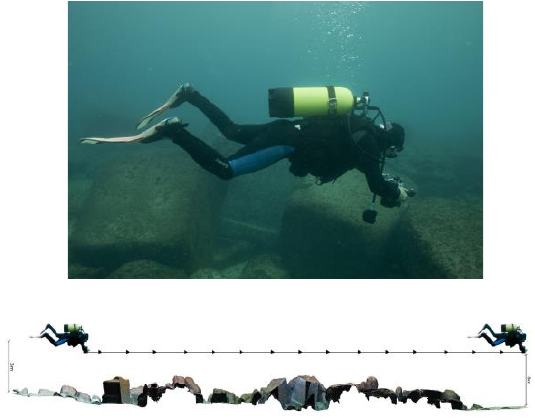
Figure. 6. Underwater photogrammetry data acquisition (photography by Philippe Soubias, processing by Mohamed